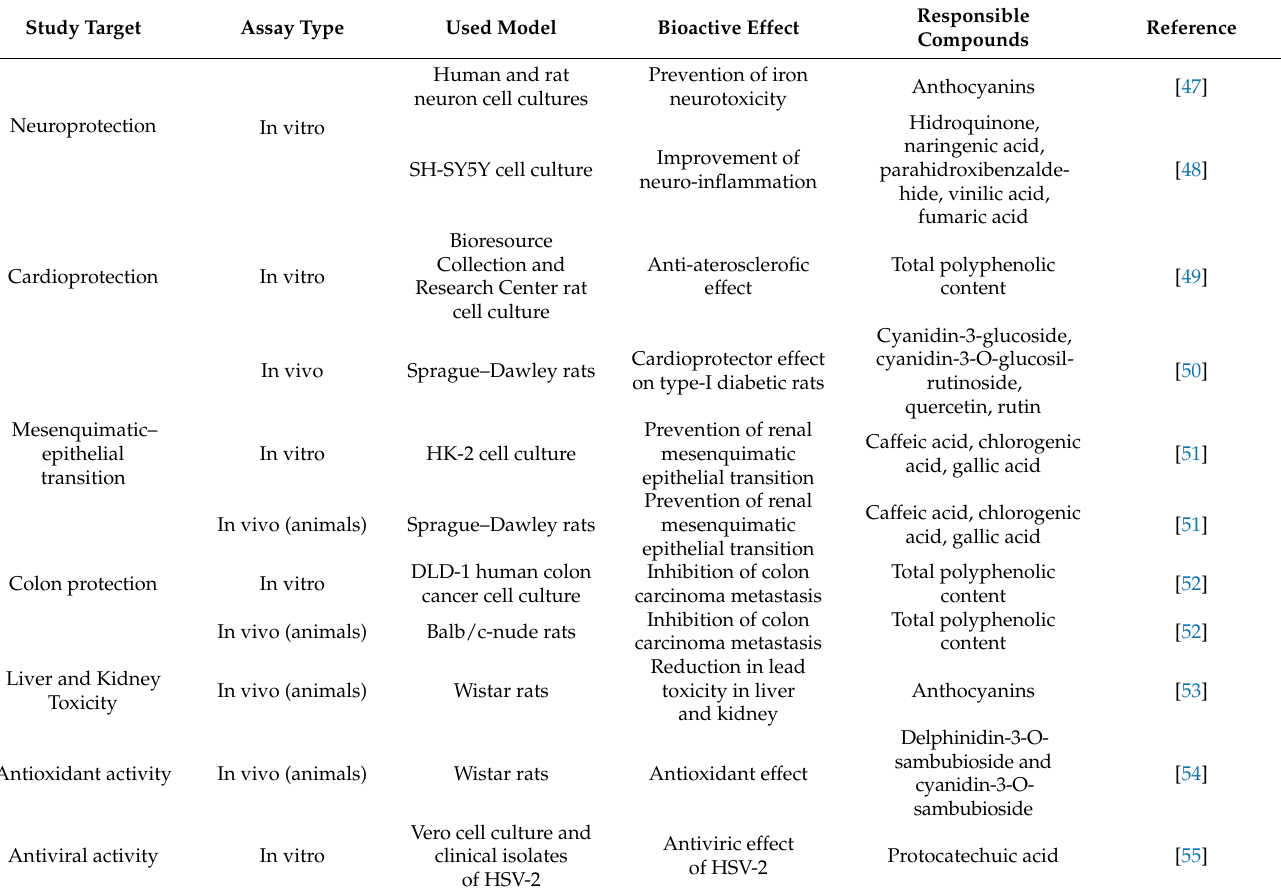
Table 3. Bioactivity of phenolic compounds from Hibiscus sabdariffa extracts on other